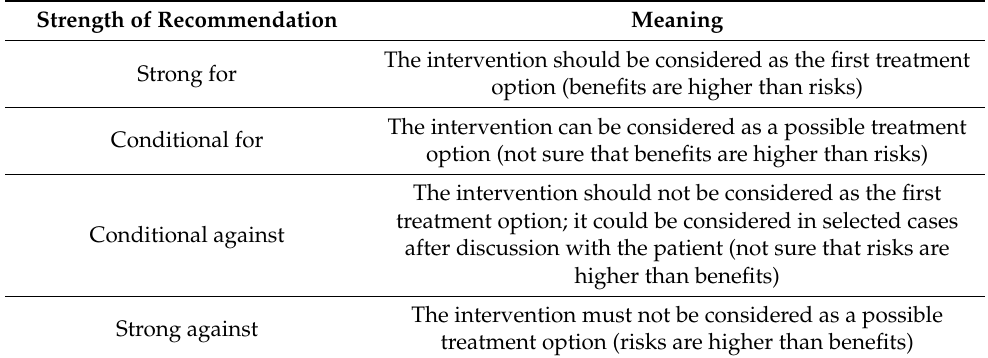
Table 2. Strength of recommendation according to the GRADE adaptation for